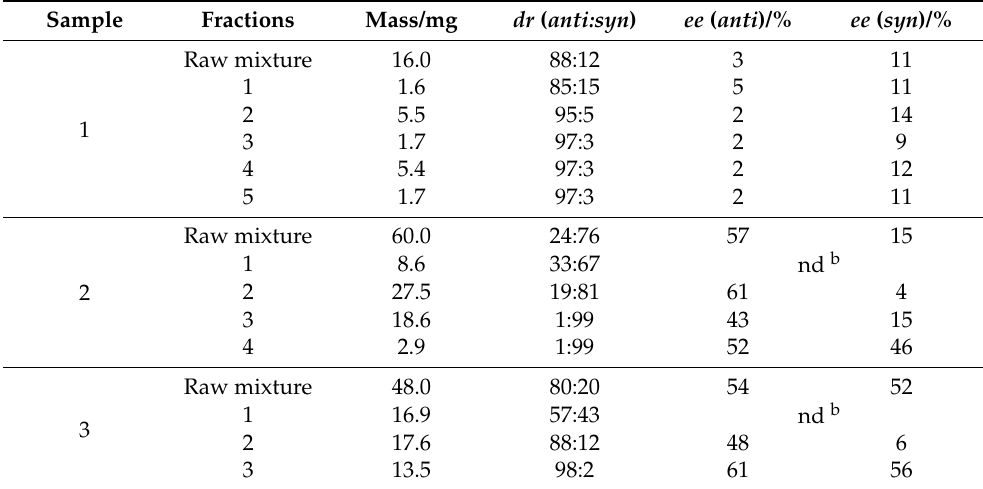
Table 2. Stereochemical effects of chromatography of aldol adducts obtained in the reaction between cyclohexanone and p -nitrobenzaldehyde a